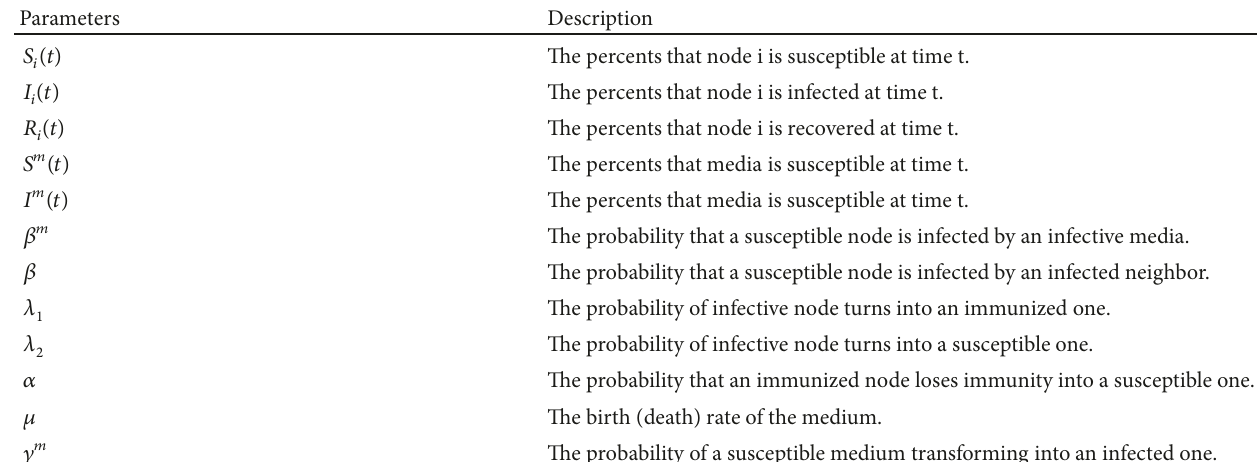
Table 1: Description of parameters.